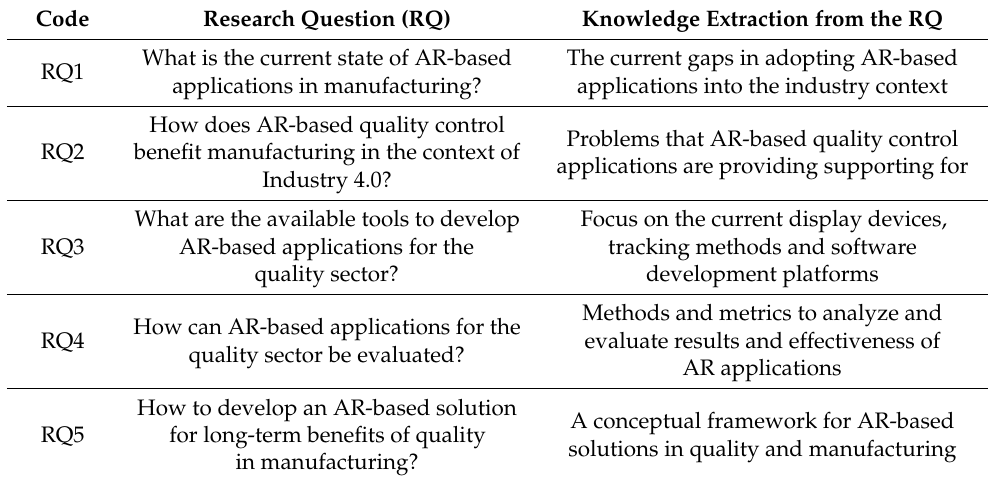
Table 1. Research